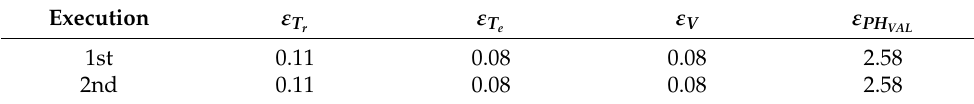
Figure 13. Measured (blue) and one-step-ahead predicted (red) R.